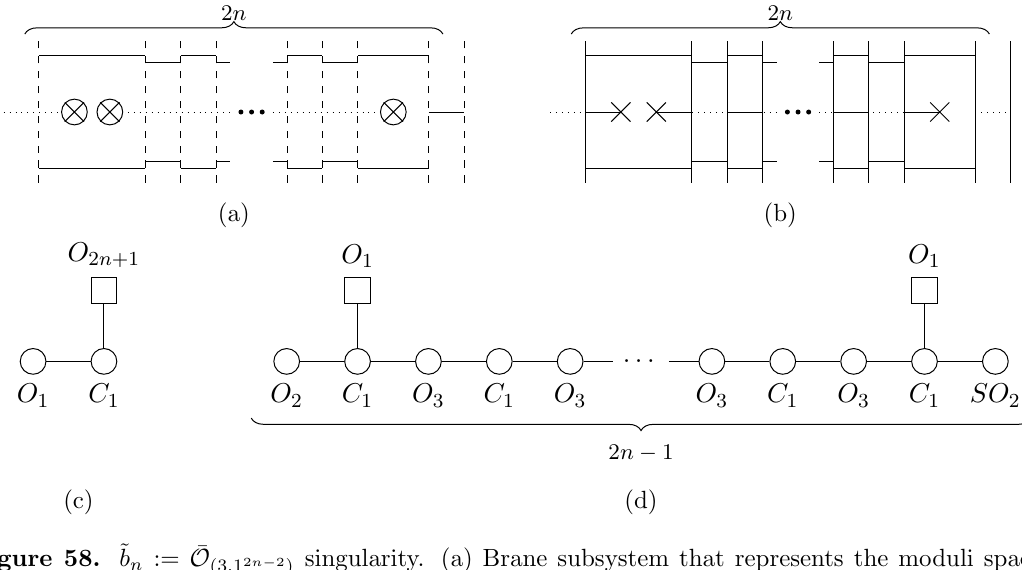
Figure 58. ~ b n := (cid:22) O singularity. (a) Brane subsystem that represents the moduli space (3 ; 1 2 n (cid:0) 2 ) generated by 2 n (cid:0) 1 D3-branes. There are a total of 2 n + 1 half D5-branes in the system. (b) After S-duality the moduli space generated by these D3-branes as a Coulomb branch. (c) Quiver corresponding to brane system (a), its Higgs branch is M H = (cid:22) O (see [47] for example). (3 ; 1 2 n (cid:0) 2 ) (d) Quiver corresponding to brane system (b), its Coulomb branch is M C = (cid:22) O (see (3 ; 1 2 n (cid:0) 2 )